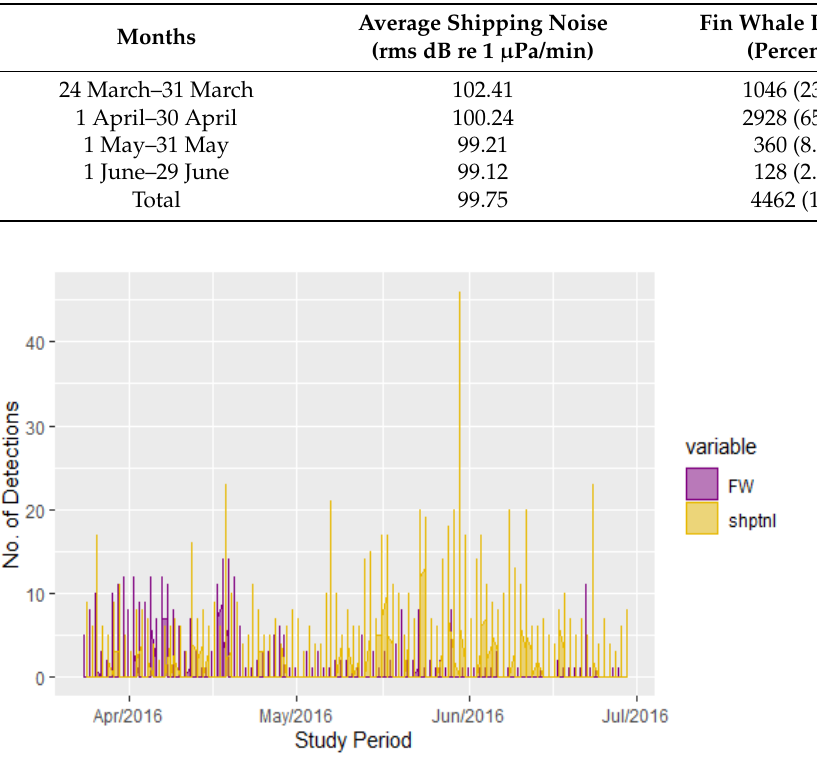
Figure 4. Time series graph showing variation of fin whale detections (FW) and shipping detections (shptnl) recorded over the period of study.